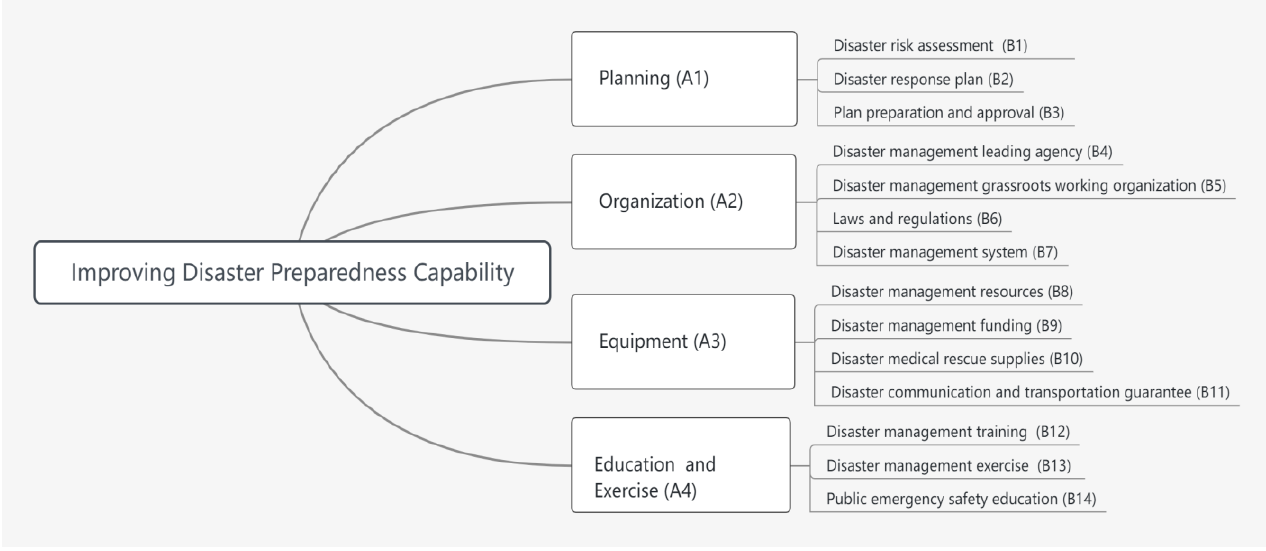
Figure 1. Comprehensive evaluation model of the disaster preparedness capability index system.